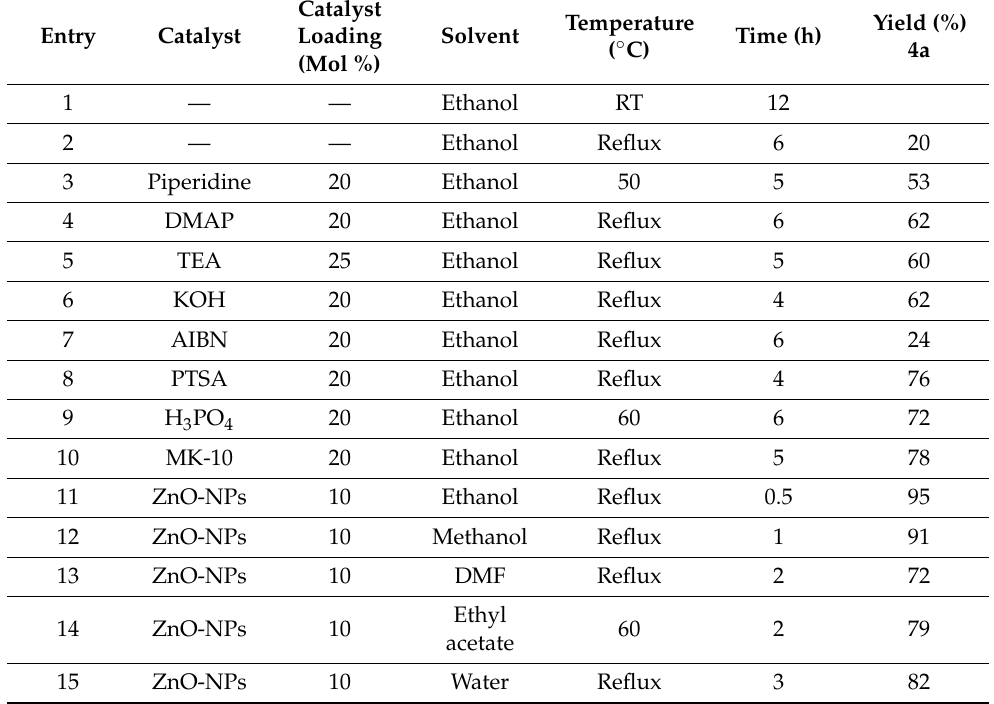
Table 3. Optimization of the reaction conditions 4a